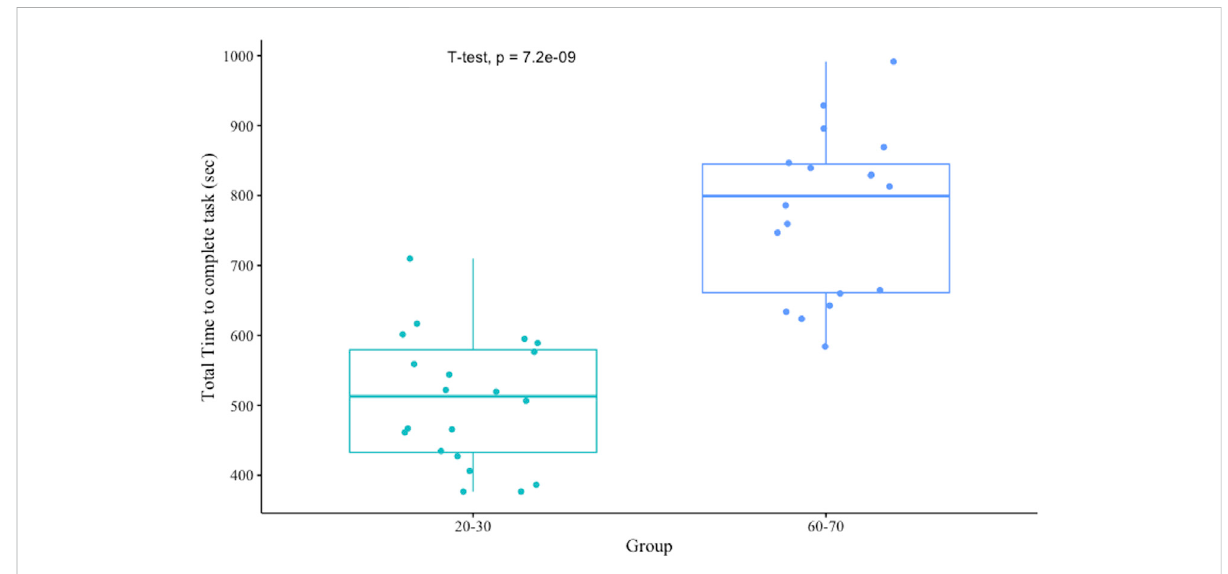
FIGURE 8 Study 2 Group Differences in VStore Total Time